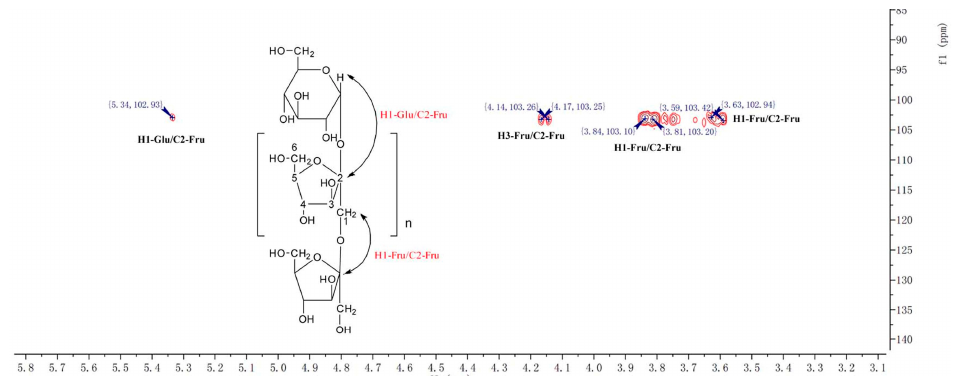
Figure 4 . HMBC spectrum of CP-A.